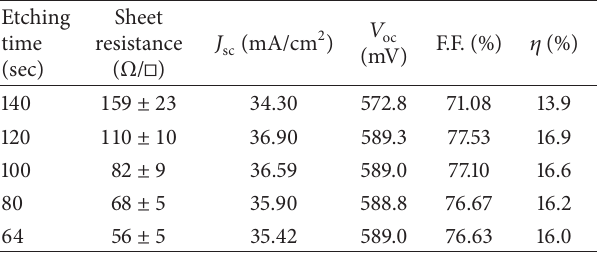
Table 1: Resultant sheet resistances and light-to-electricity param- eters for five sets of selective emitter cells after applying different etching-back time periods.